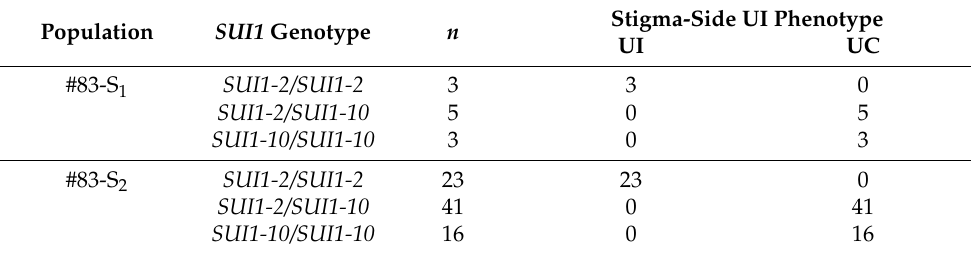
Table 3. Segregation analysis of SUI1 allele in the selfed progeny of